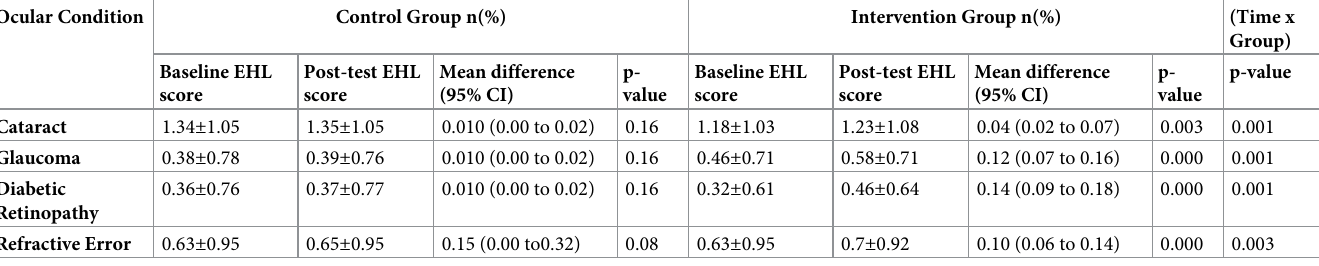
Table 3. The changes in EHL scores between the pre-and post-test assessment between the two groups. Ocular